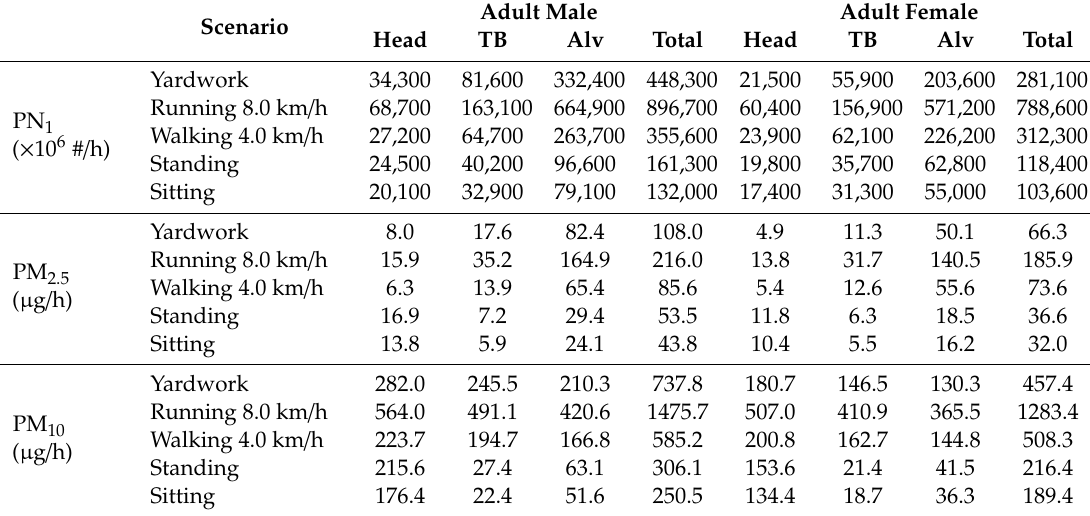
Table 8. Mean regional dose rates (head, tracheobronchial (TB), alveolar (Alv), and total) for aerosol exposure during TYPE IV indoor activities. Note that yardwork is assumed to be equivalent to housework and running is equivalent to indoor